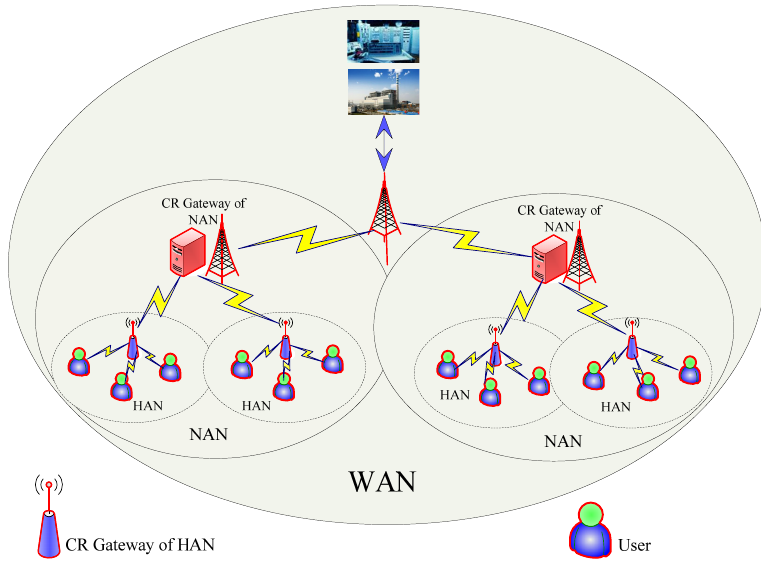
Figure 1. Three-layer architecture of the Smart Grid communication